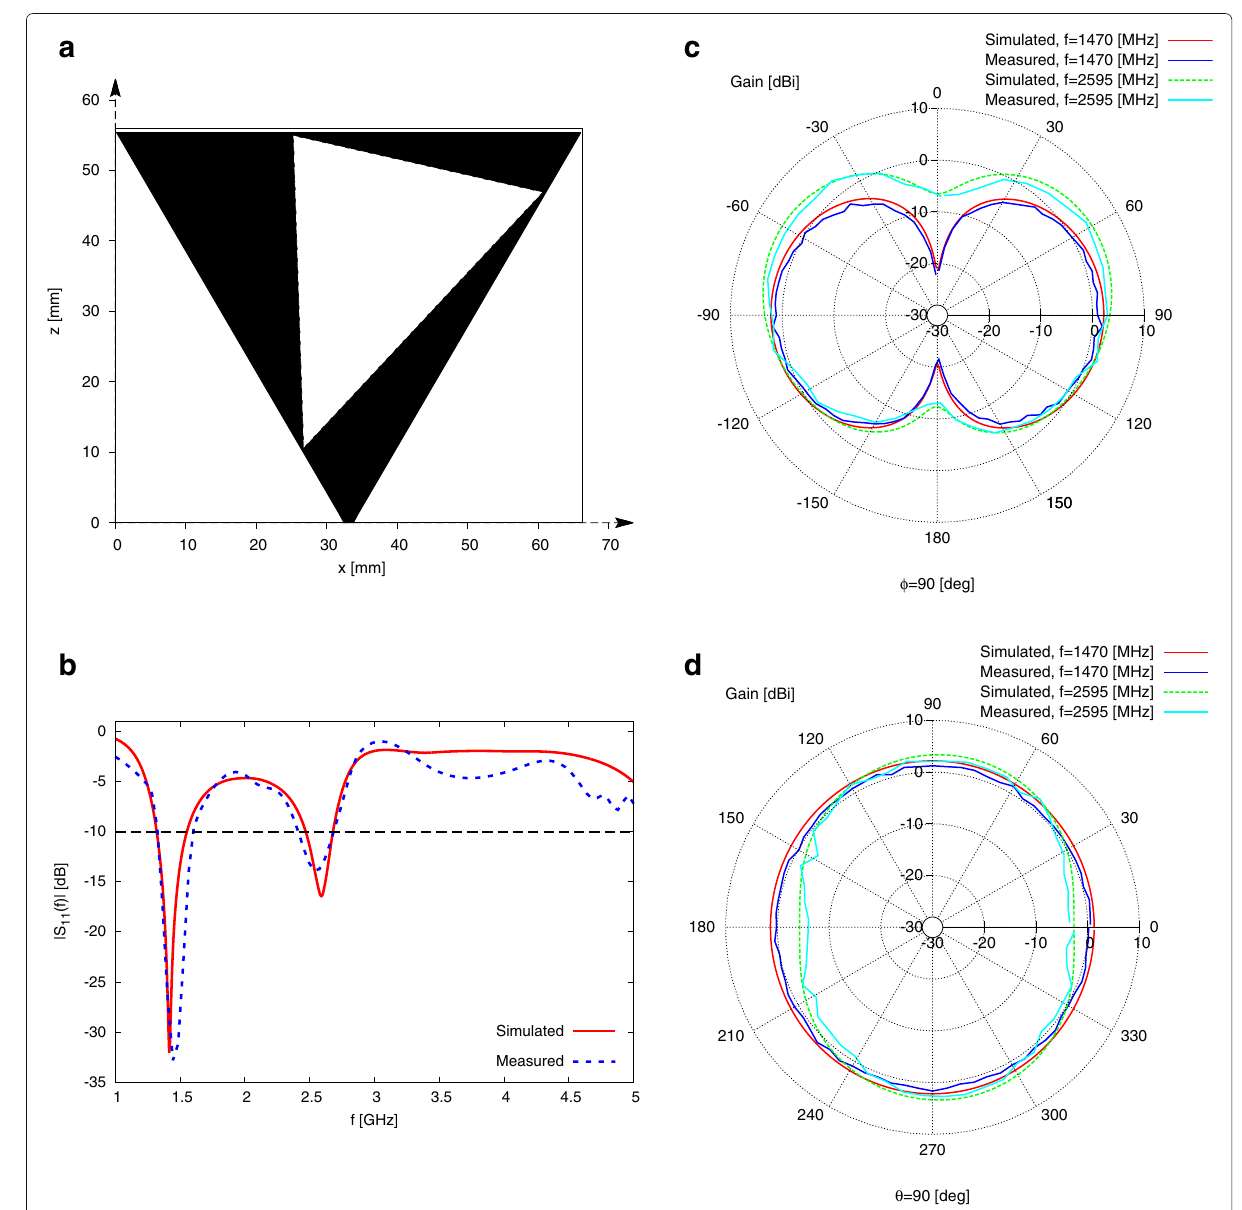
Fig. 7 SbD validation (WCDMA-1500 and LTE-2600 bands). Front view of optimized layout ( a ). Simulated/measured behavior of b the associated scattering parameter and radiation patterns at 1.47 GHz and at 2.595 GHz when c ϕ = π